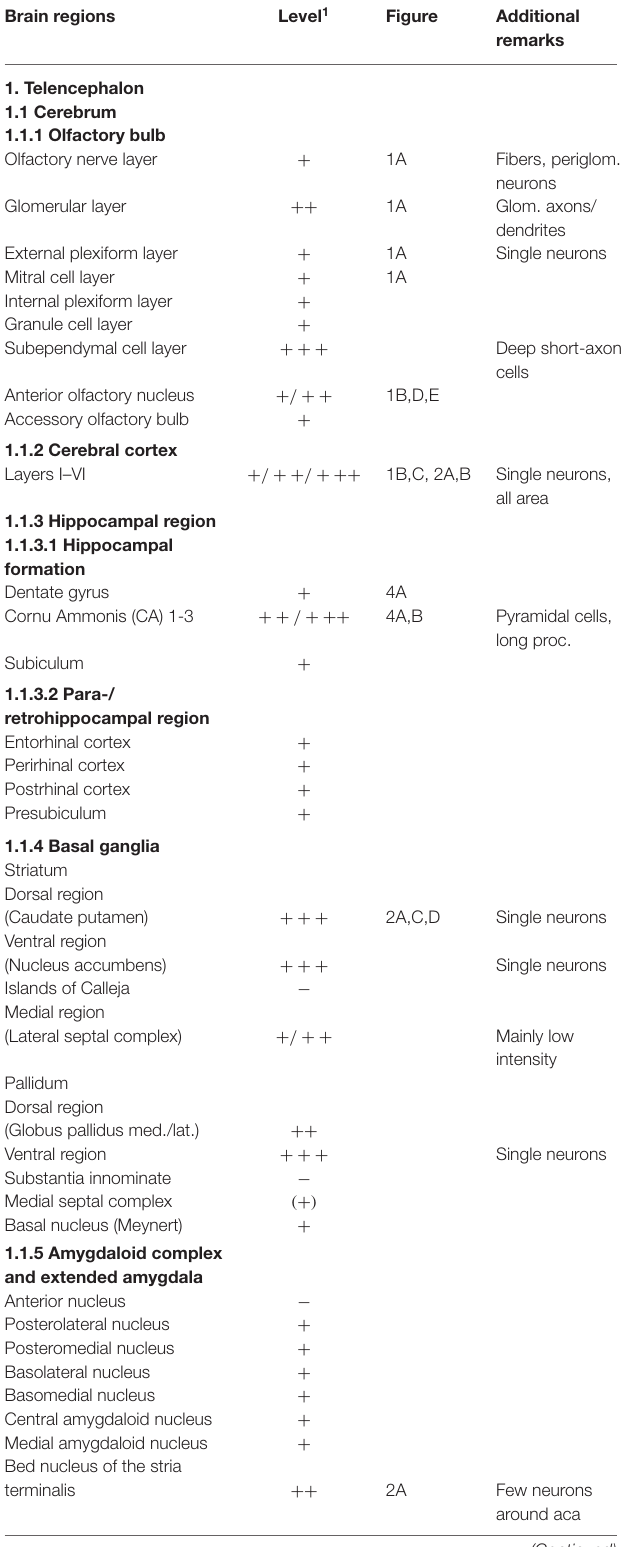
TABLE 1 | Distribution of cytoglobin-immunoreactive (Cygb-IR) neuronal somata in the mouse brain